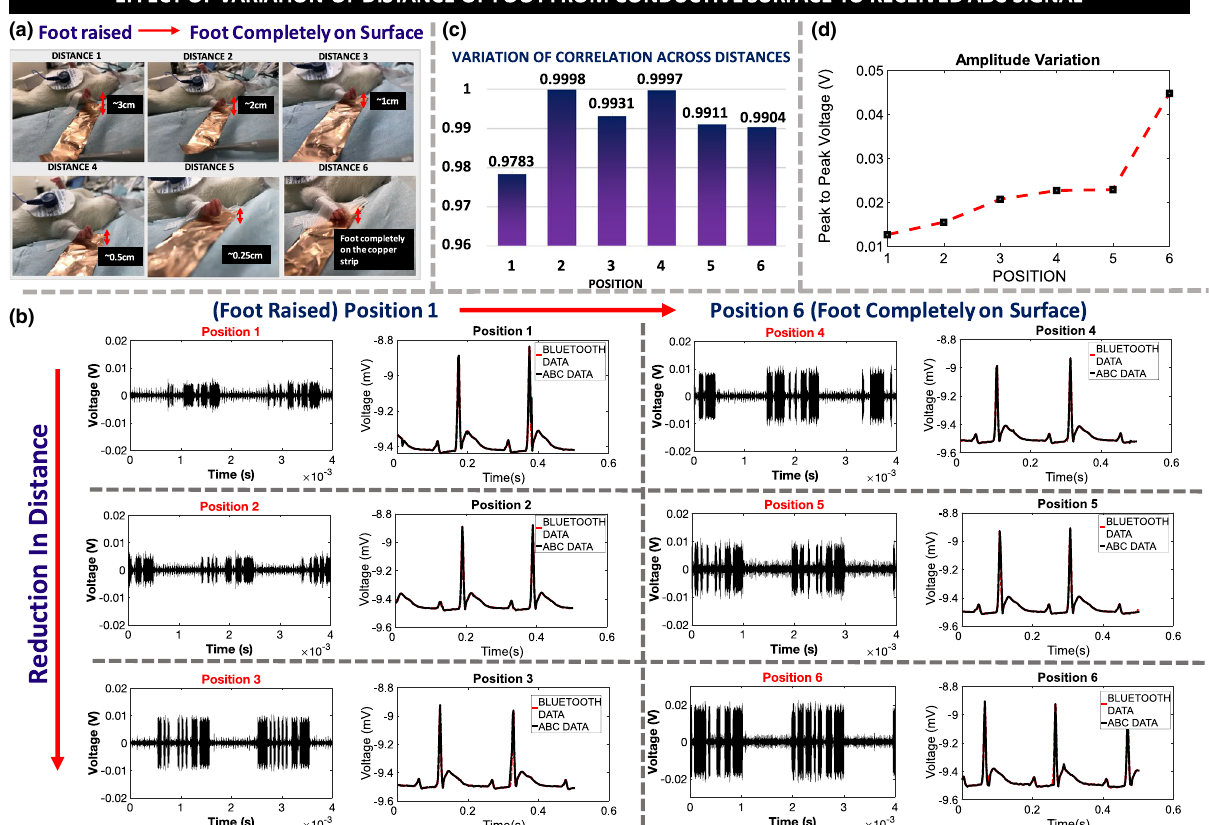
Figure 7. Effect of distance on received signal strength: ( a ) Experimental setup to measure the effect of distance variation on received OOK signal; In position 6, the rat foot is closest to the conductive surface and in position 1 the foot is furthest from the conductive surface. ( b ) Received OOK signals of different distance variations and the decoded signals for the different distances ( c ) Correlation between Bluetooth and ABC received signals as a function of distance, each depicting correlation > 97% . ( d ) Variation in the amplitude of the received signal as a function of distance, for a transmitter amplitude of 3.3